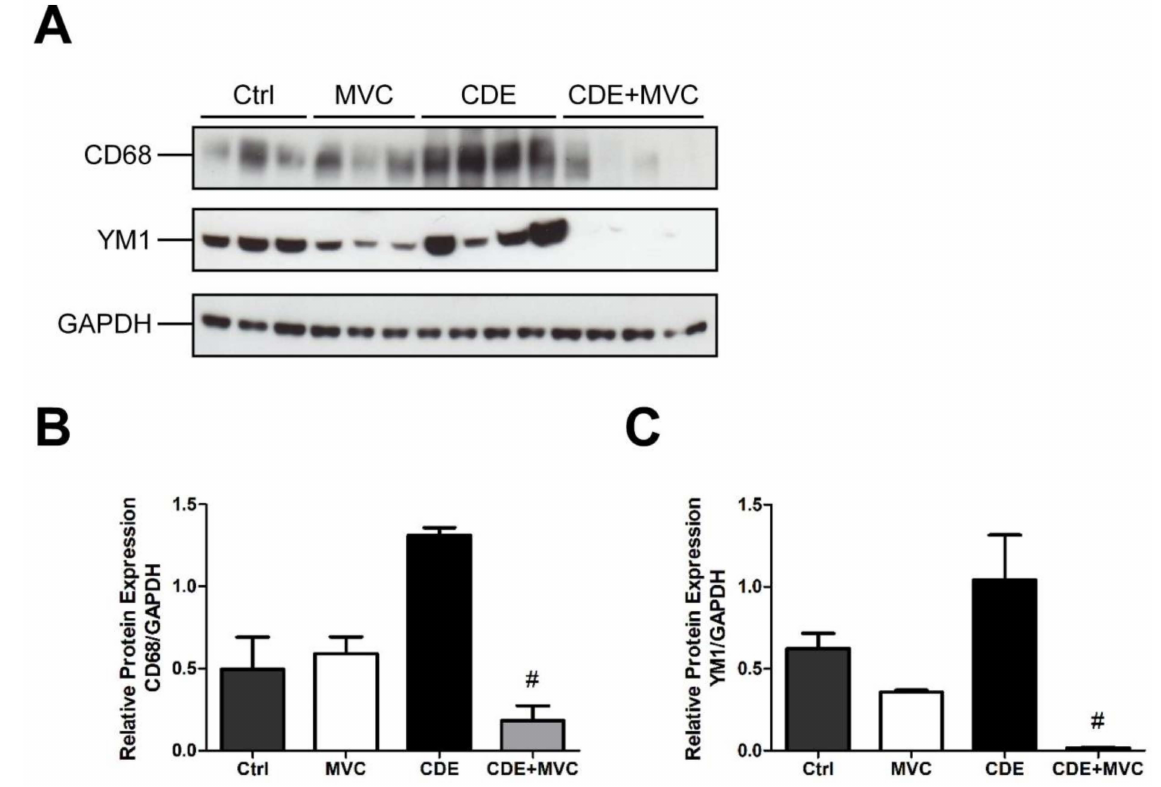
Figure 8. MVC diminishes CDE-induced M2 polarization of macrophages. ( A ) Protein lysates from livers of mice fed Control, CDE, MVC and CDE+MVC diets for 16 weeks were immunoblotted and labelled for CD68, YM1 and the loading control GAPDH. ( B , C ) Abundance of each protein relative to its control, was calculated through densitometry performed on the images. Bars represent means + SEM for n = 3 mice in the Ctrl and MVC groups and n = 4 in the CDE and CDE+MVC groups. # p < 0.05 compared to CDE